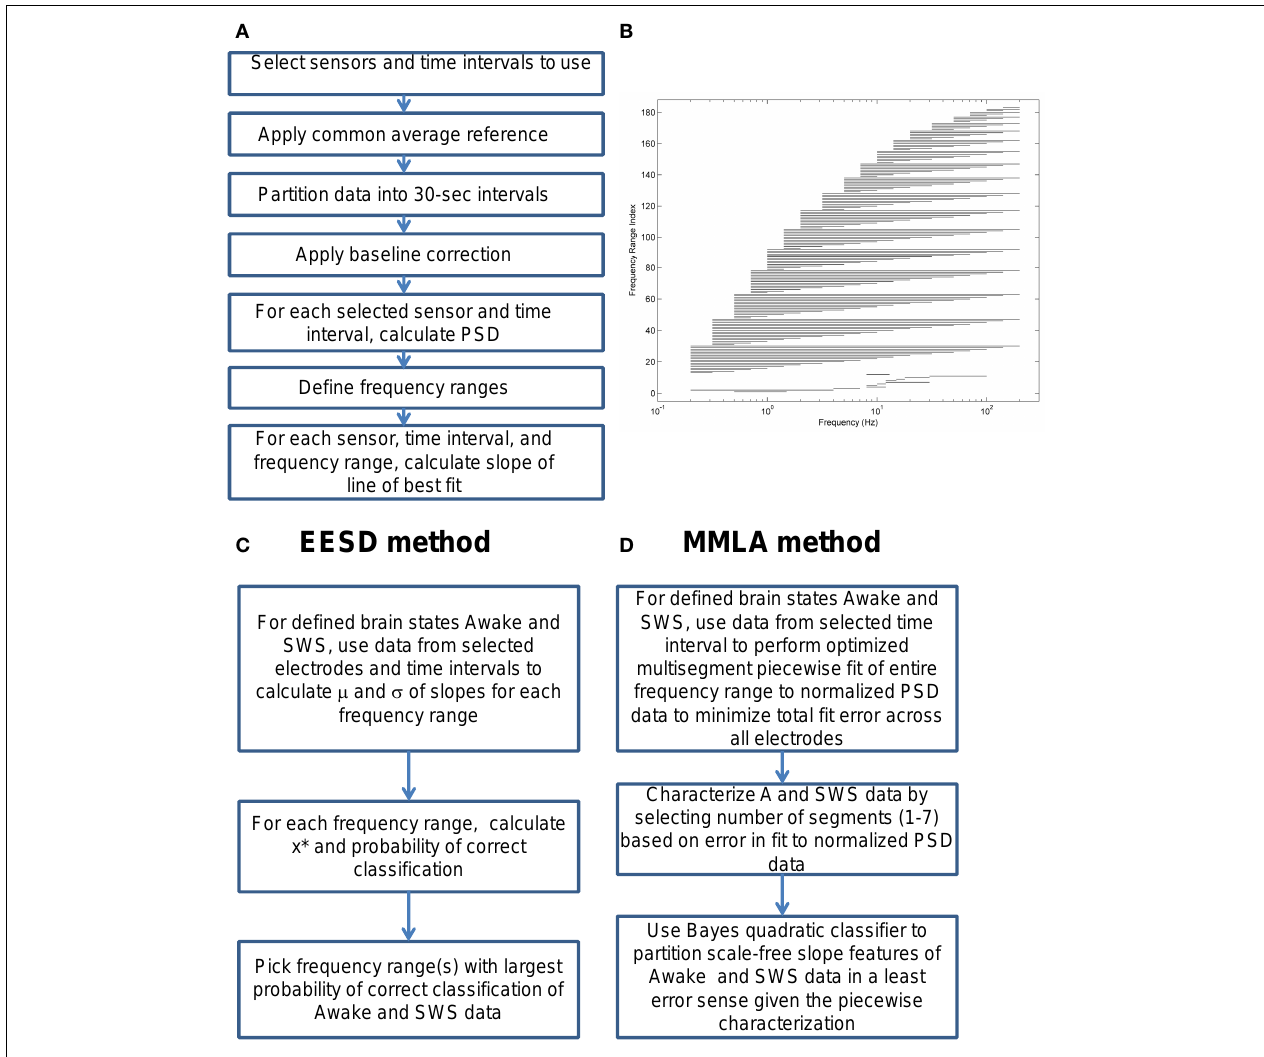
FIGURE 1 |Analysis steps. (A) Preprocessing steps. (B) Frequency ranges. (C) EESD method. (D) MMLA method.